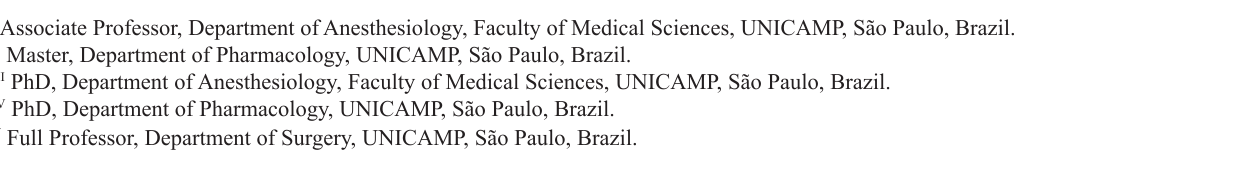
fígados dos ratos expostos ou não ao fenobarbital. A concentração e dose de rocurônio utilizadas nos experimentos in vitro e in vivo foram respectivamente de 4 µg/mL e 0,6 mg/kg. Resultados: In vitro e in vivo , o fenobarbital não alterou a amplitude das respostas musculares. In vitro , o bloqueio produzido pelo rocurônio foi significativamente diferente (p=0.019) entre expostos (20%) e não expostos (60%); in vivo o bloqueio foi significativamente maior (p=0.0081) nos ratos tratados (93,4%). As concentrações